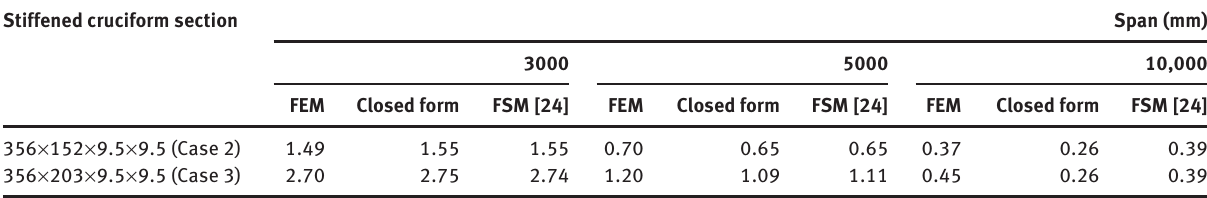
Table 13 Effect of the vertical (or horizontal) stiffener width on the normalized critical buckling stresses. Stiffened cruciform section